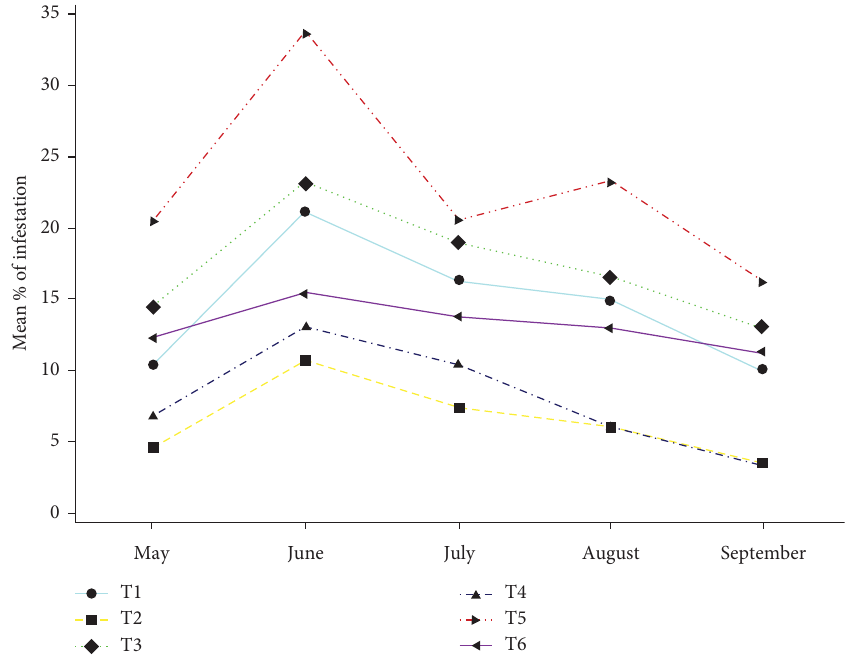
Figure 3: Monthly changes in the infestation of Hypothenemus hampei according to the interaction between shade levels and cofee variety. (T1no shade × var. Catimor, T2no shade × var. Caturra, T3medium shade × var. Catimor, T4medium shade × var. Caturra, T5high shade × var. Catimor, and T6high shade × var. Caturra).